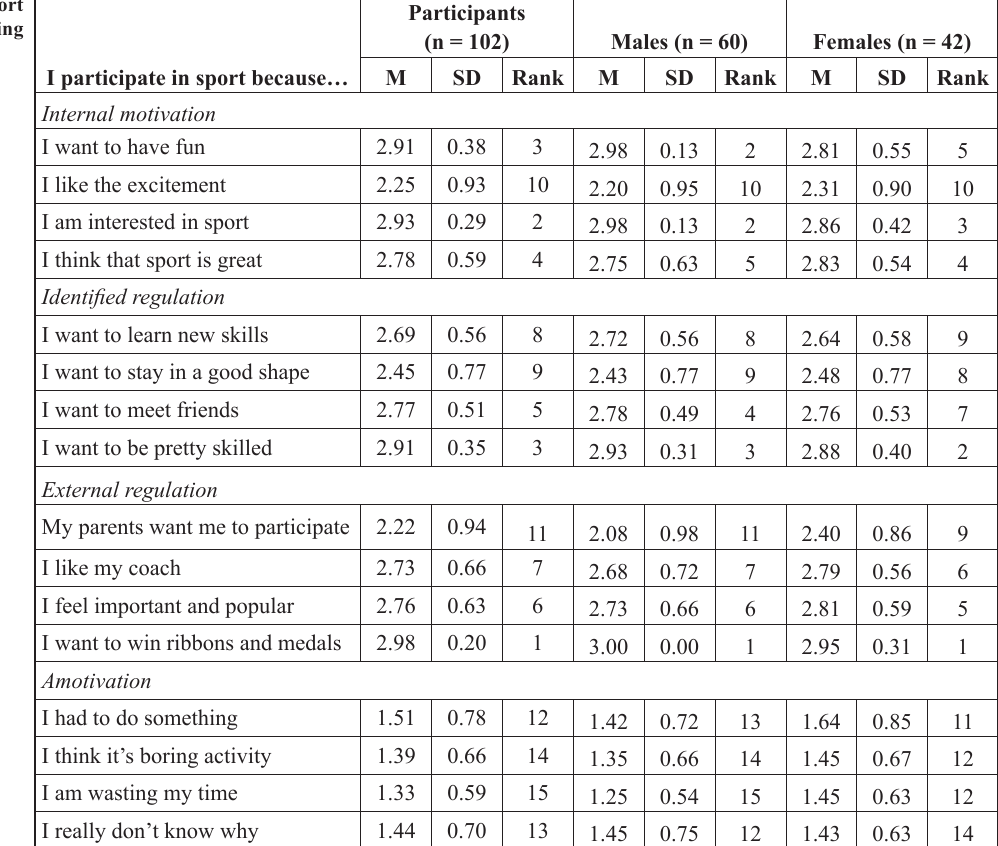
Table 2. Data on Sport Motivation According to the